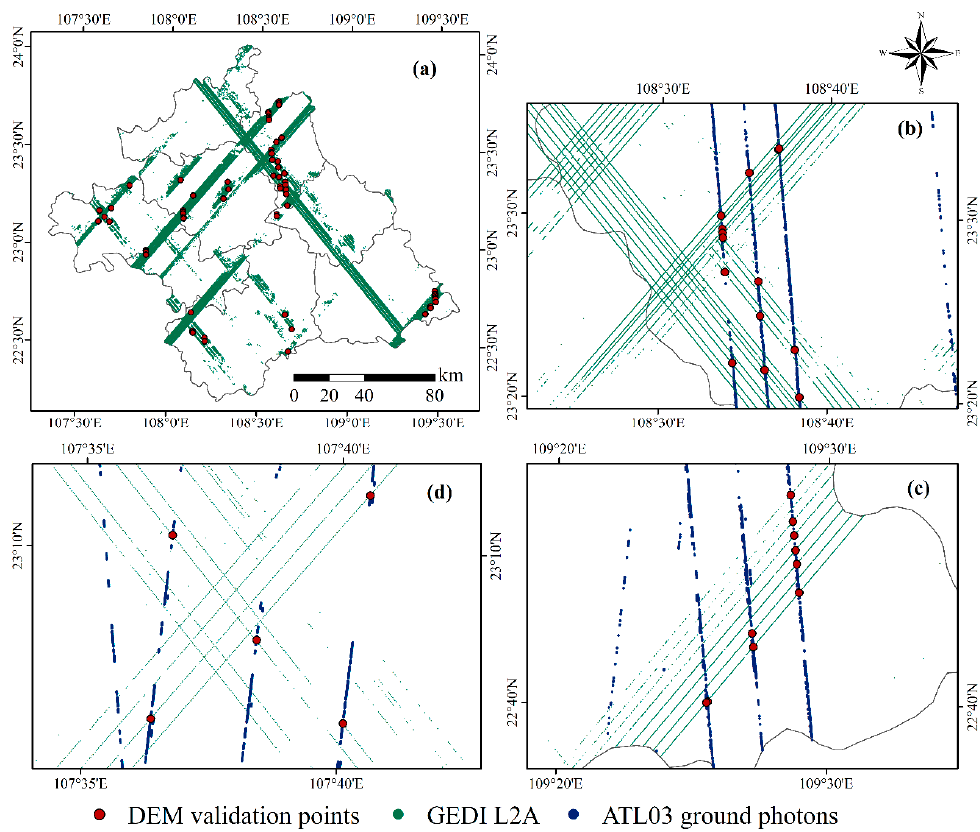
Figure 3. GEDI and ICESat-2 ground tracks. Red dots indicate that the ground photons average value and the GEDI footprint are located within the same 30 m × 30 m pixels of Landsat 8 images, that is, the intersection points (more details are in Section 2.3.1). In pictures ( a – d ), red dots denote the same. ( a ) shows the overall distribution while ( b – d ) show enlarged displays. The green lines in all images are made up of dense GEDI footprints.